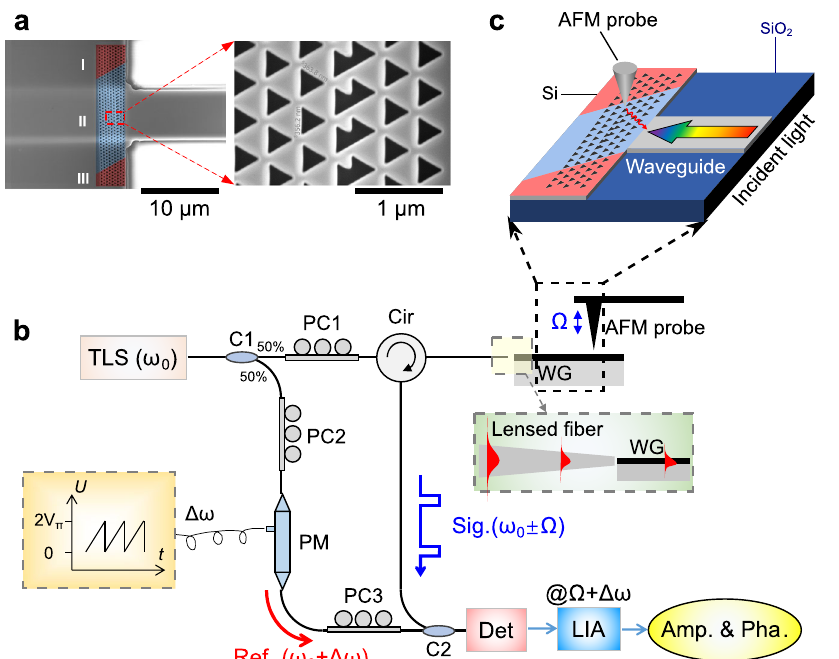
Fig. 3 SEM image and the schematic diagram of the electric fi eld detection. a SEM images of the sample. Barrier regions and the dispersing region are colored by pseudo red and blue respectively to display different regions more clearly visually. The width of the pattern for regions (I, II, and III) is 4.5 μ m in the x- direction, the length is 22 μ m in the y- direction, and the length of region II for rainbow is 16 μ m. b Experimental setup of all- fi ber re fl ection-based s -SNOM. TLS: tunable laser source; C1, C2: in-line 50:50 directional couplers; PC1, PC2, PC3: polarization controller; Cir: circulator; WG: waveguide under test; PM: LiNbO 3 phase modulator; V π : half wave voltage of PM; Det: InGaAs photodetector; LIA: digital lock-in ampli fi er. c Ampli fi ed schematic diagram of the electric fi eld detection based on the s -SNOM system in ( b